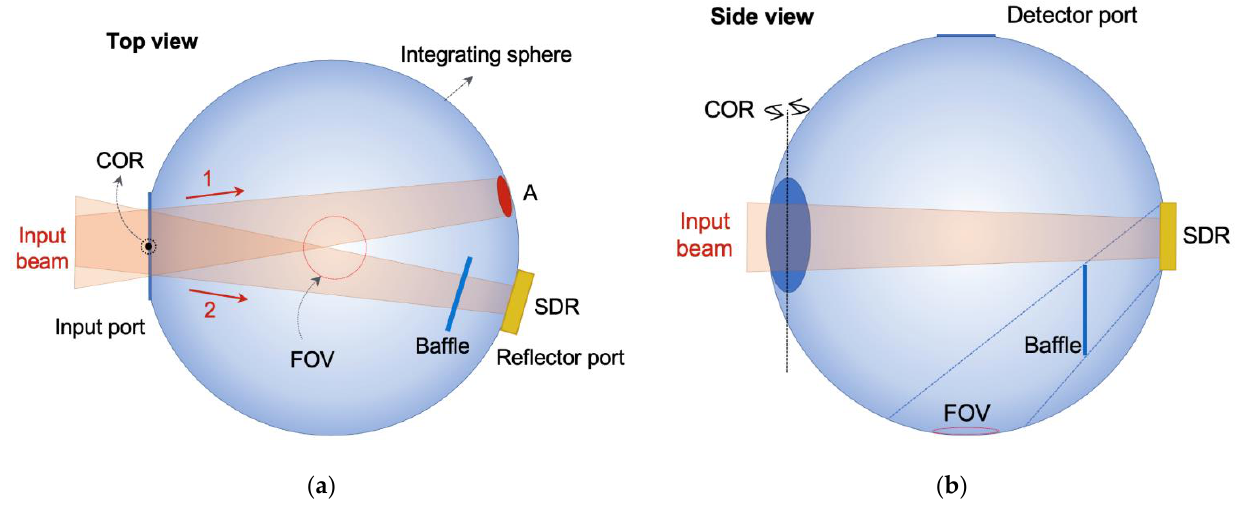
Figure 1. ( a ) Top view and ( b ) side view schematics of the absolute reflectometer integrating sphere. (FOV: field of view, A: area where input beam first illuminates, SDR: standard diffuse reflector, COR: center of rotation).